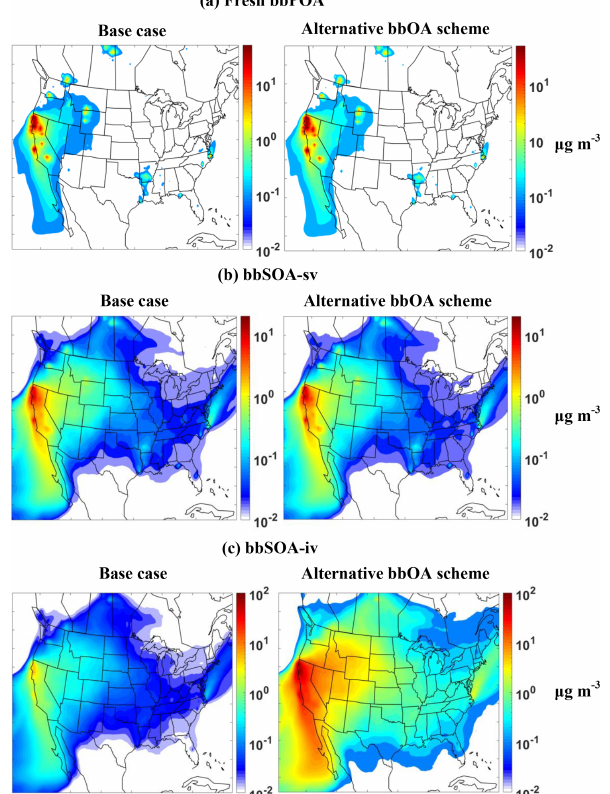
Figure 3. PMCAMx-SR-predicted ground-level concentrations of (a) fresh bbPOA, (b) SV-bbSOA-sv, and (c) SV-bbSOA-iv from all biomass burning sources during September 2008. Left column refers to the base case simulations and right column to the simula- tions with the alternative bbOA scheme. All concentrations are in µgm − 3